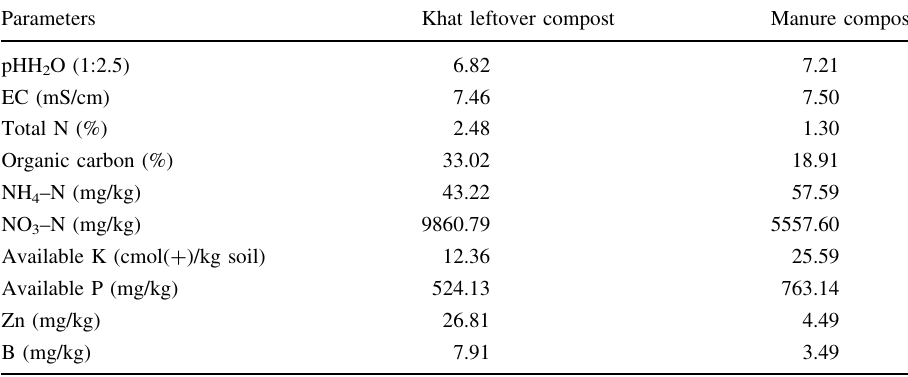
Table 1 The selected chemical properties of khat leftover and manure compost